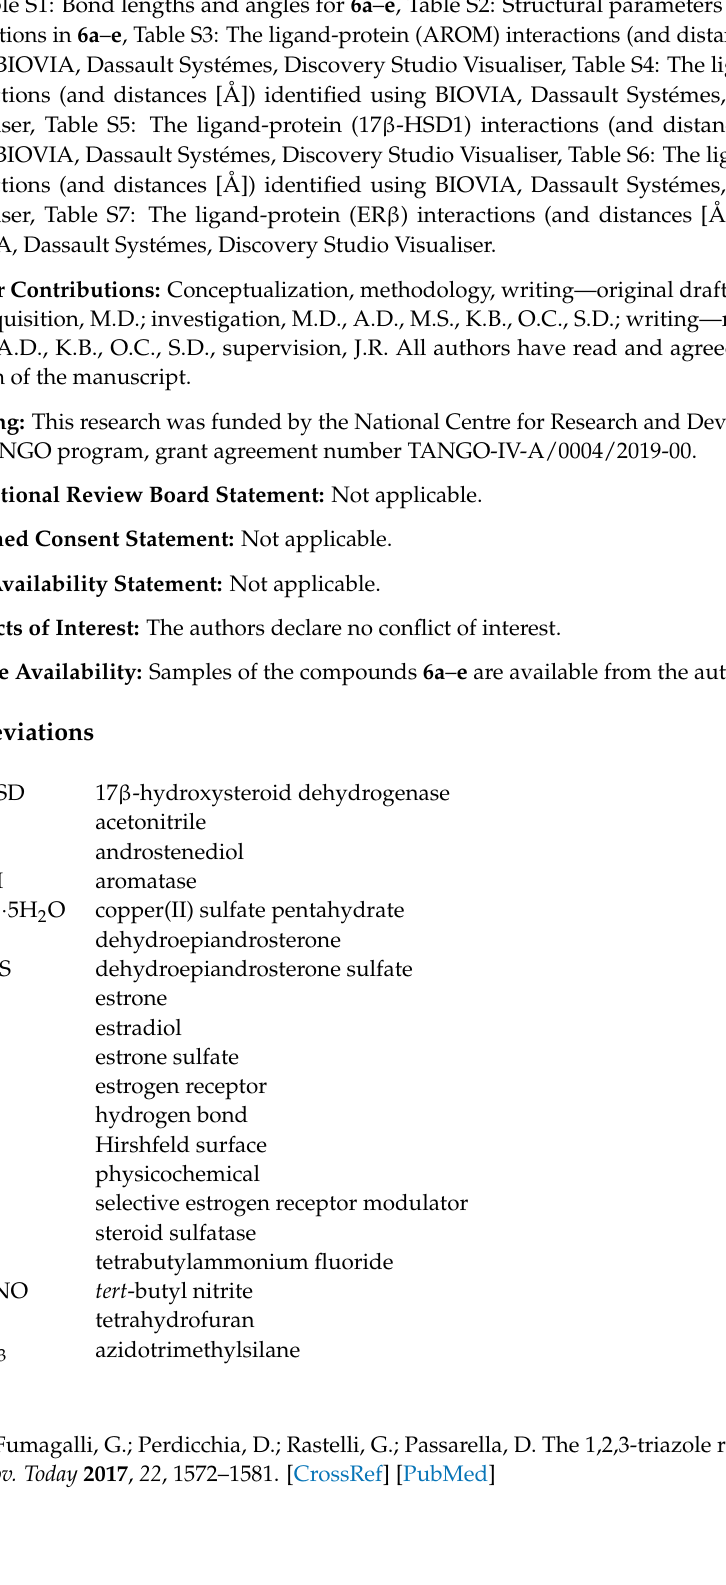
Figure S3: Crystal packings and intermolecular interactions in 6b ., Figure S4: Crystal packings and intermolecular interactions in 6c ., Figure S5: Crystal packings and intermolecular interactions in 6e , Table S1: Bond lengths and angles for 6a – e , Table S2: Structural parameters for intramolecular interactions in 6a – e , Table S3: The ligand-protein (AROM) interactions (and distances [Å]) identified using BIOVIA, Dassault Syst é mes, Discovery Studio Visualiser, Table S4: The ligand-protein (STS) interactions (and distances [Å]) identified using BIOVIA, Dassault Syst é mes, Discovery Studio Visualiser, Table S5: The ligand-protein (17 β -HSD1) interactions (and distances [Å]) identified using BIOVIA, Dassault Syst é mes, Discovery Studio Visualiser, Table S6: The ligand-protein (ER α ) interactions (and distances [Å]) identified using BIOVIA, Dassault Syst é mes, Discovery Studio Visualiser, Table S7: The ligand-protein (ER β ) interactions (and distances [Å]) identified using BIOVIA, Dassault Syst é mes, Discovery Studio